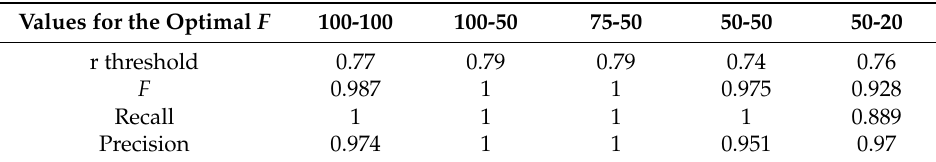
Table 4. Optimal values for the F score for each configuration.